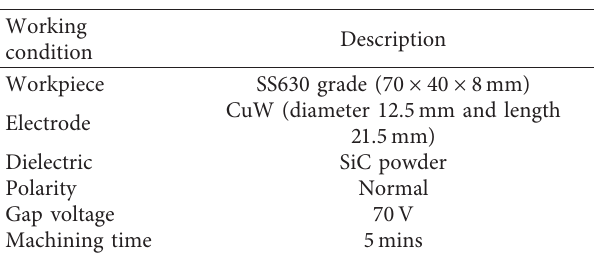
Table 5: Experimental